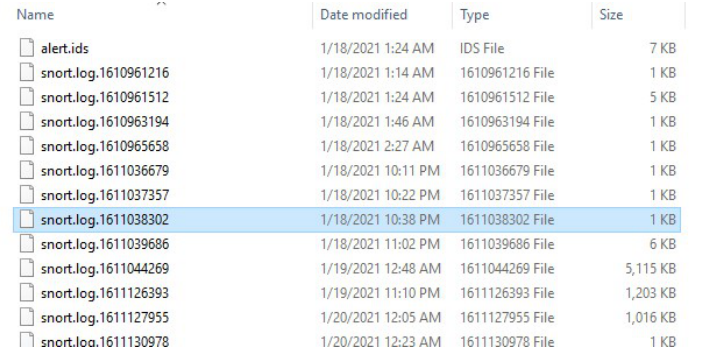
Figure 5. Logs and alerts generated by the